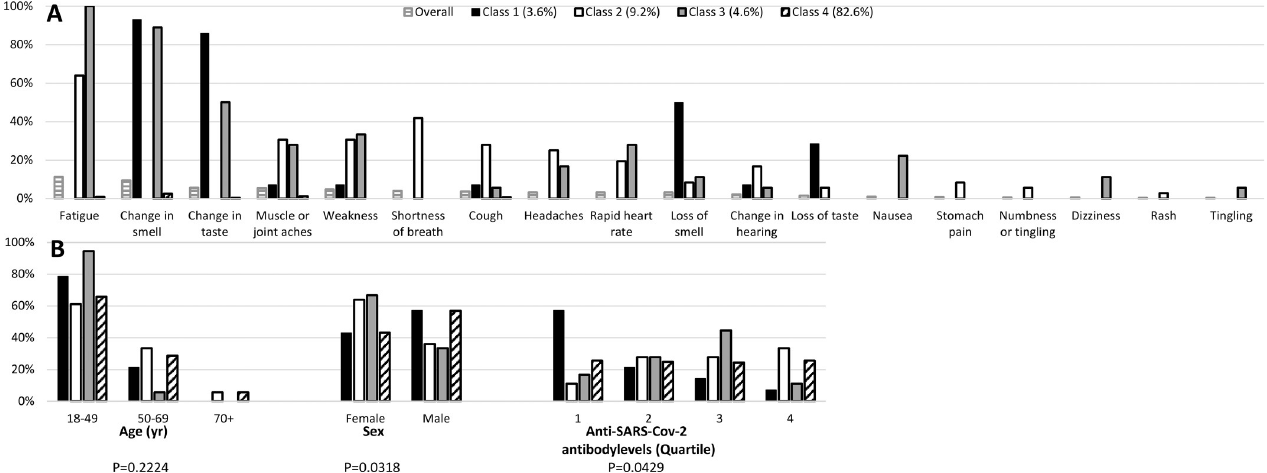
Fig 4. Latent class analysis of patterns of chronic COVID-19 symptoms. Latent Class Analysis was used to examine patterns of binary variables of chronic SARS-CoV-2 symptoms in adults. LCA used the observed binary data to identify homogeneous patterns, i.e. n = 4 latent classes. Conditional probabilities were estimated using maximum likelihood to characterize the latent classes. (A) Conditional probability plots are presented, where probabilities closer to 0 or 1 indicate lower or higher chances, respectively. The horizontal black lines represent the overall distribution of SARS-CoV-2 symptoms. The black solid fill represents Class 1. The white solid fill represents Class 2. The gray solid fill represents Class 3. The diagonal black lines represent Class 4. The proportion of respondents who are members of these classes is presented. B. Chi-square tests were performed comparing (B) age, sex and SARS-CoV-2 IgG antibody levels with class